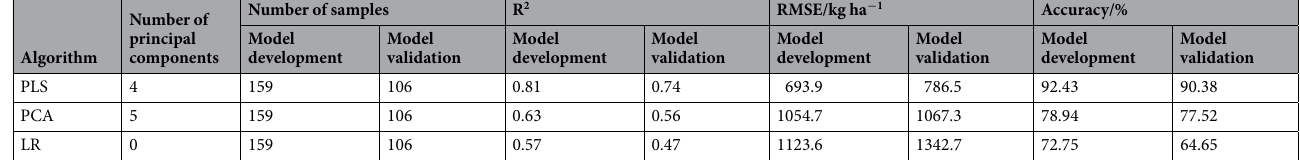
Table 3. Comparison of predicted results with PLS, LR and PCA.